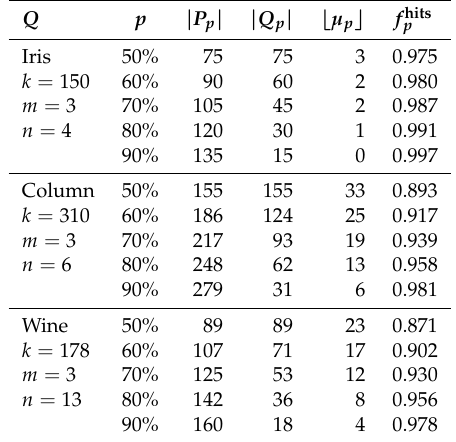
Table 2. Similarity valuation LBNN classification performance for the application